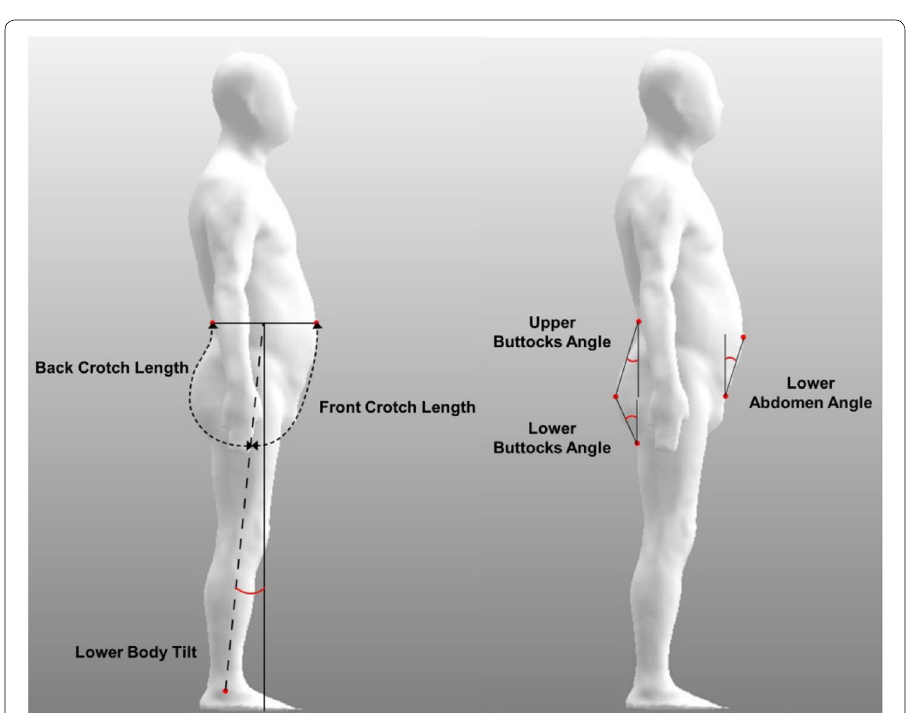
Fig. 2 Measurement methods of lengths and